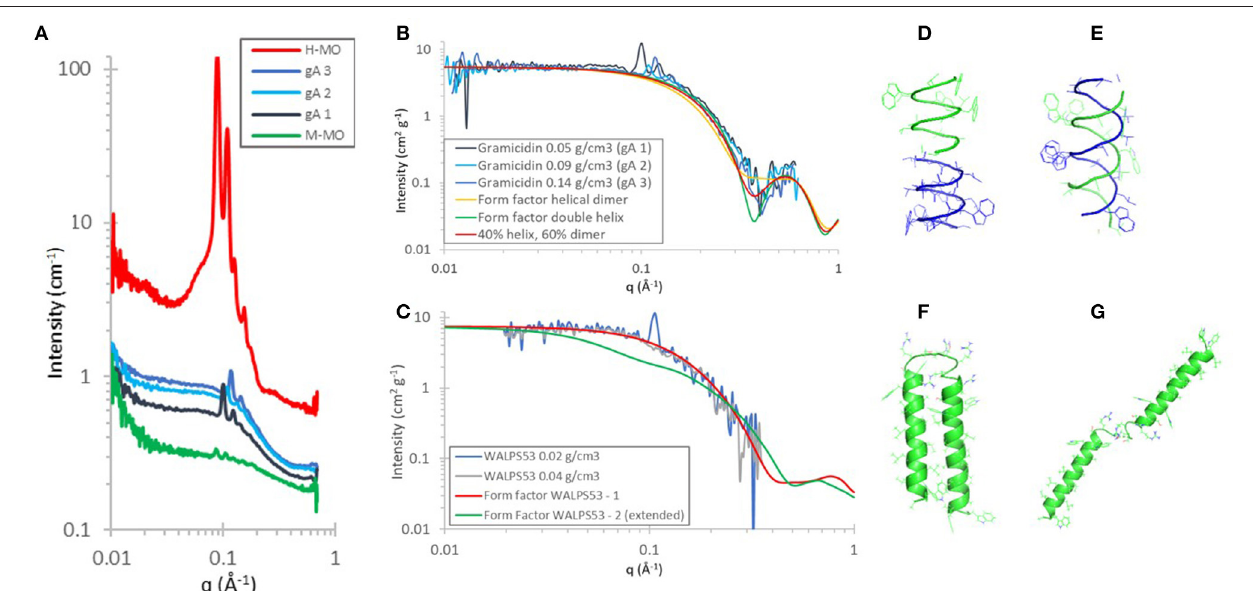
FIGURE 1 | (A–C) SANS data showing H-MO and peptide encapsulation in 92% D-MO/8% H-MO (M-MO) at a range of peptide concentrations at 20 ◦ C in D 2 O. (A,B) Gramicidin A (1.9 kDa) concentrations reflect 1.6, 3.1, and 5.3 mol% with respect to MO and at 40% v/v D 2 O: diamond cubic Q D II phase. (C) WALPS53 (5.9 kDa) at 0.2 and 0.4 mol% with respect to MO and at 35% v/v D 2 O: gyroid cubic Q G II phase. The SANS data was treated by first subtracting the MO cubic phase as background, then scaled to peptide concentration, and then a further incoherent background was subtracted. The calculated form factors were obtained using CRYSON. (D–G) were created using PyMOL and show cartoon representations of the secondary structures with side-chains shown as lines. They were obtained using PDB ID (D) 1MAG: helical dimer and (E) 1BDW: double helix. (F) WALPS53–1 dimer as generated using the iTasser server ( Yang et al., 2015) and (G) WALPS53–2 (extended version of